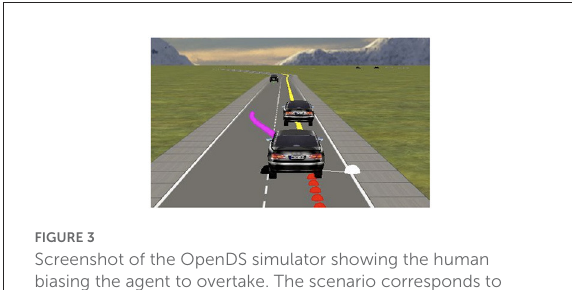
FIGURE3 Screenshot of the OpenDS simulator showing the human biasing the agent to overtake. The scenario corresponds to Figure 4(i), showing the affordances a in yellow and b in purple.